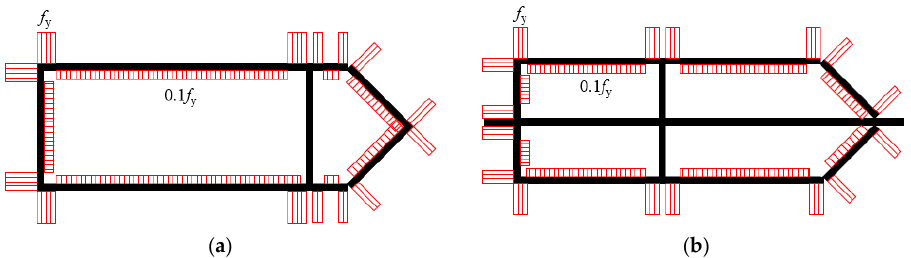
Figure 12. Distribution of residual stresses. ( a ) 2-cell specimens; ( b ) 4-cell specimens.